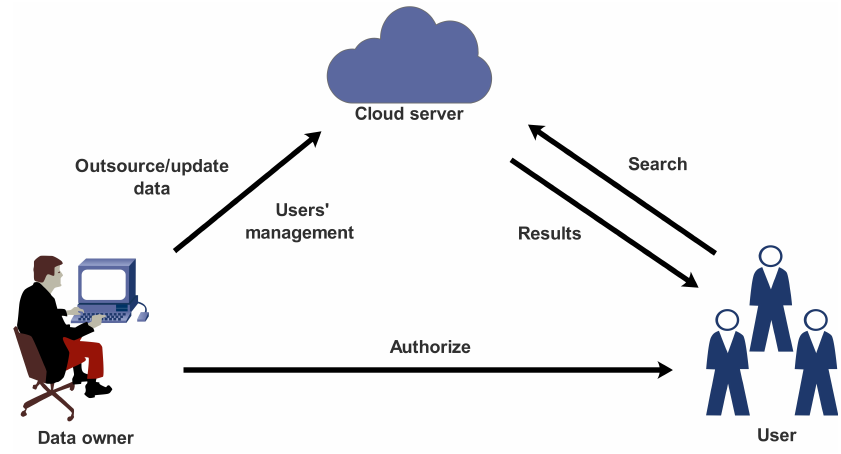
Figure 1. Architecture of multi-user searchable symmetric encryption with dynamic